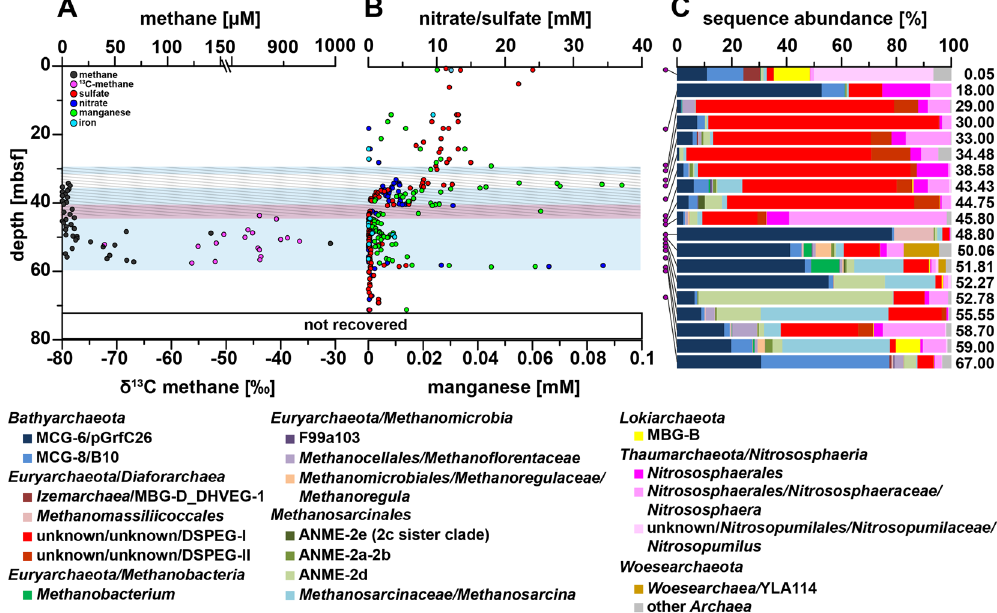
Figure 1. Pore water profiles of methane, nitrate, sulfate, manganese and relative archaeal abundance in the Mamontov Klyk core C2. ( A ) Methane concentrations are shown in black and corresponding δ 13 C-values in magenta 19 . ( B ) Nitrate concentrations are shown in blue, sulfate concentrations in red, manganese concentrations in green, and iron concentrations in light blue. ( C ) Purple dots on the left show depth location in the core. Relative abundance of archaeal 16S rRNA gene sequences are shown as bar plots. Colors of bars refer to the taxa in the legend below figure. Numbers on the right refer to the exact depth in the core. ANME = ANaerobic MEthanotrophic archaea, DHVEG-1 = Deep Hydrothermal Vent Euryarchaeotal Group 1, DSPEG = Deep Submarine Permafrost Euryarchaeotal Group, MBG-B = Marine Benthic Group B, MBG-D = Marine Benthic Group D, MCG = Miscellaneous Crenarchaeotal Group. The shaded area represents the permafrost degradation zone, the red area a sulfate-methane transition zone, and the light blue areas ice-bonded permafrost. All uncolored areas of the plots correspond to unfrozen submarine permafrost and marine